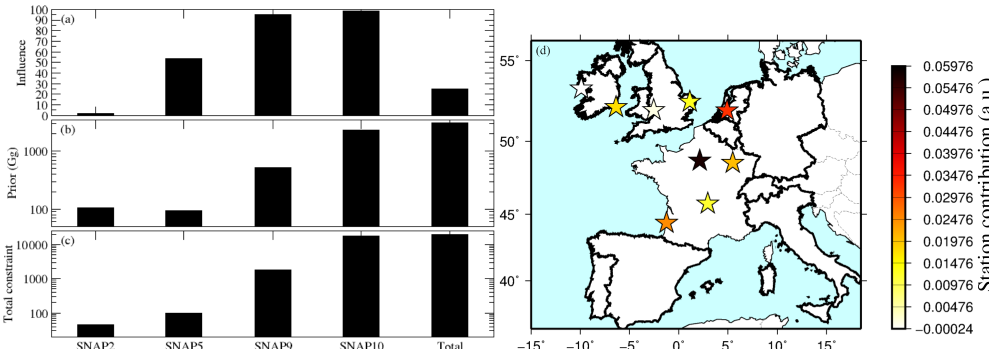
Figure 7. Constraints obtained for the sectorial run (described in Sects. 3 and 3.3). The influence matrix ( a , influence given in % for the whole domain over the whole year) is de-aggregated according to prior fluxes (b) to obtain the constraints (c) : the annual sum of constraints on CH 4 emissions in the whole domain by the atmospheric data is shown on a logarithmic scale (adimensional). Only fluxes independent from initial and boundary conditions are used (see Sect. 4.1). Only the sectors which are actually seen are displayed. The relative contributions of the stations in the inversion, averaged over the year, are shown on an arbitrary scale (map), white being for a small